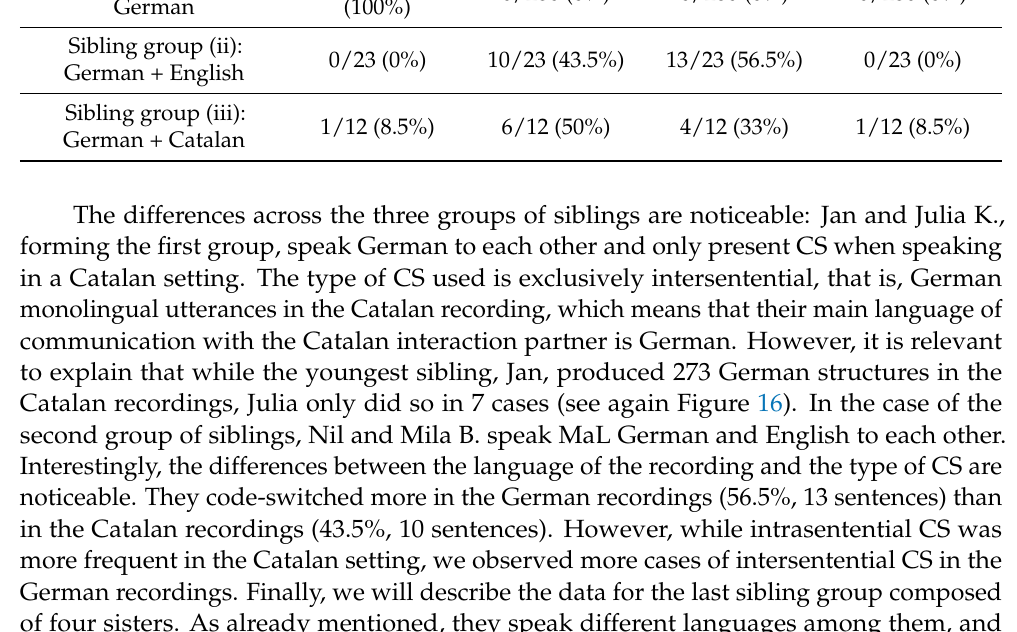
Table 6. Inter- and Intrasentential CS according to each sibling group. CS in the Catalan Recording CS in the German Recording Inter CS Intra CS Inter CS Intra